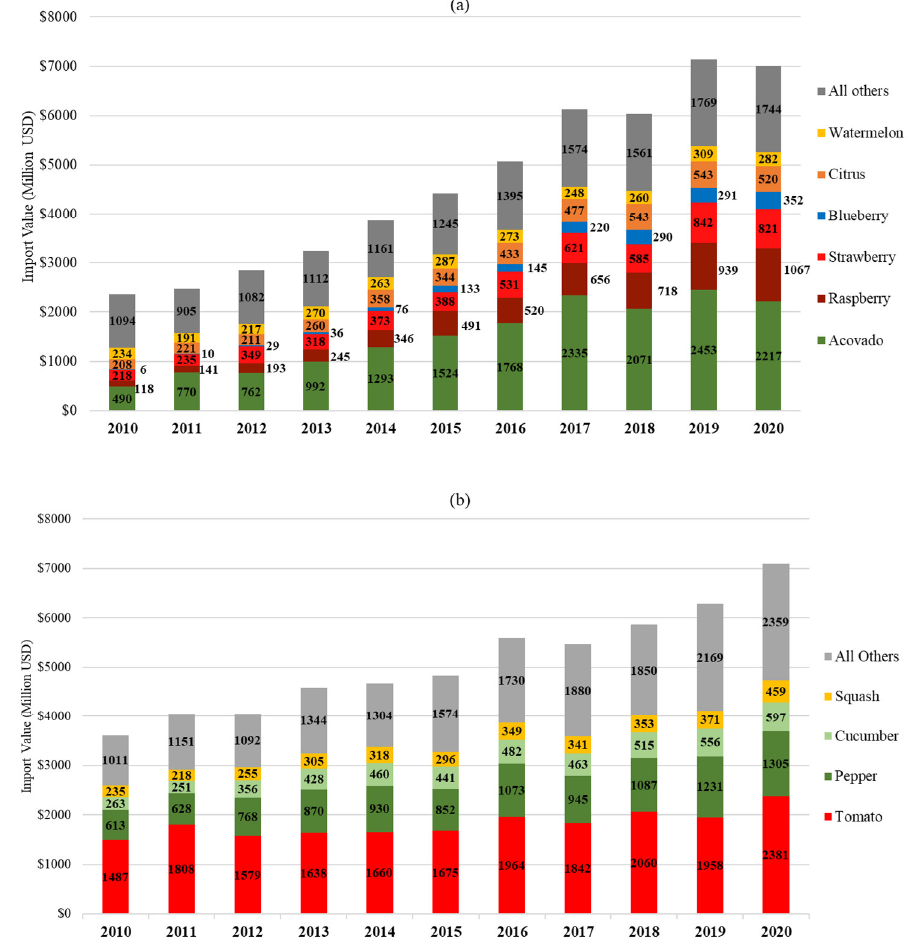
Figure 4. ( a ) Upper panel: value of major fresh fruit imports from Mexico from 2010 to 2020; ( b ) lower panel: value of major fresh vegetable imports from Mexico from 2010 to 2020. Source: USDA FAS [11] .